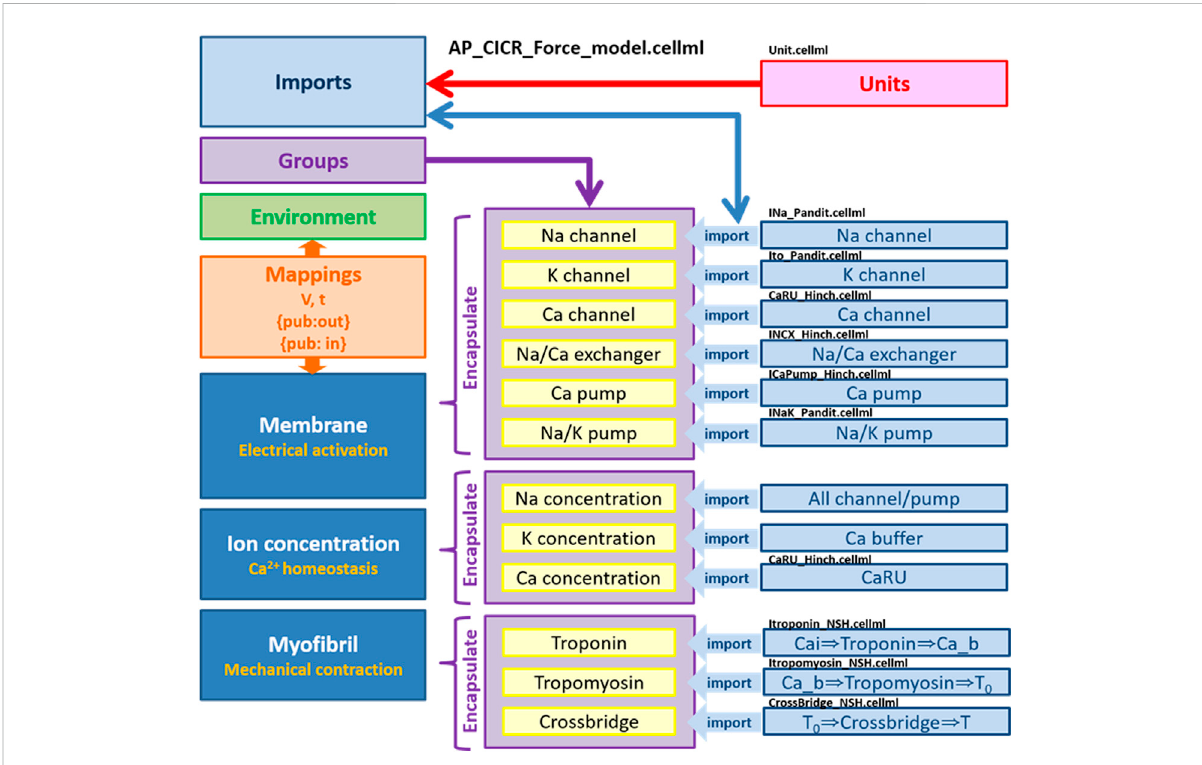
FIGURE 8 Overall structure of biophysical whole cell model (AP_CICR_Force_model) showing the encapsulation hierarchy (purple), the CellML model imports (blue) and the other key parts (units, components and mappings) of the top level CellML model (Kim,